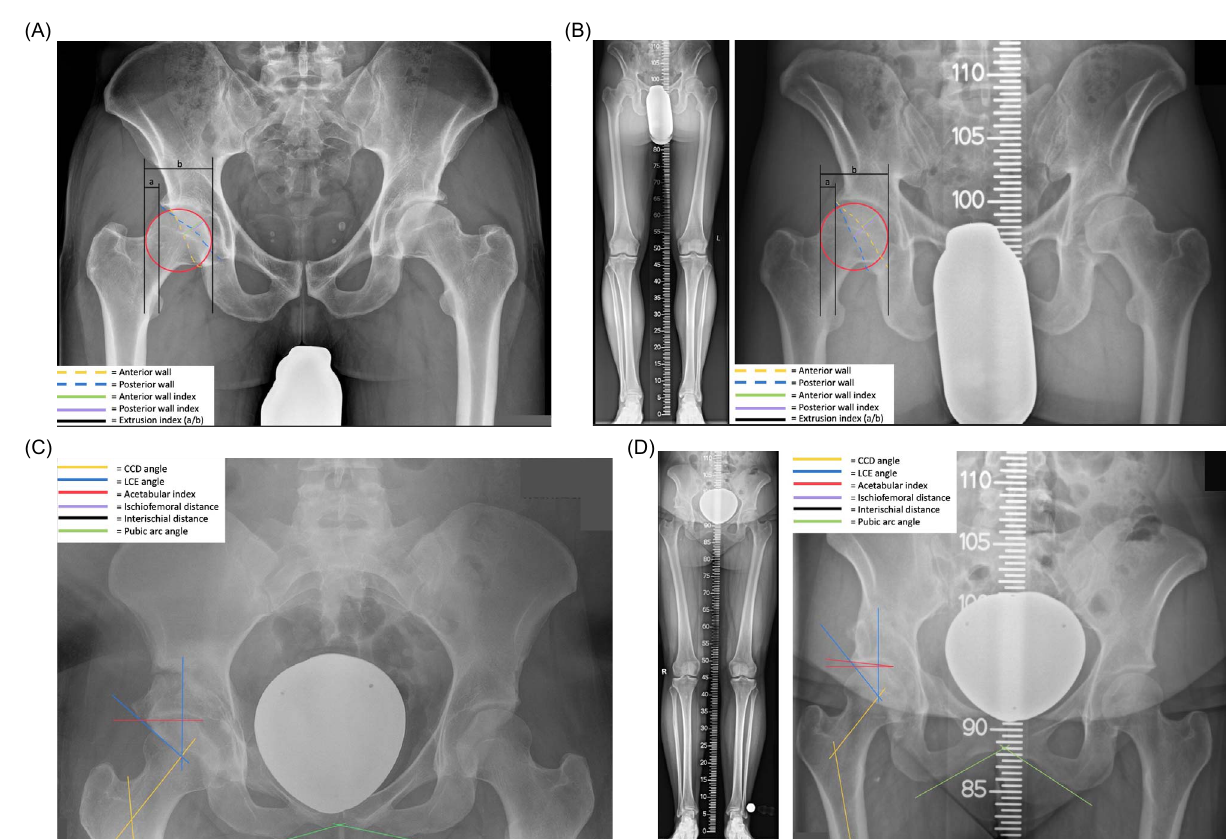
Figure 1. (a – d): Illustration of radiographic measures used for morphometric analysis of the hip in conventional ap pelvic X-rays and full- length weight-bearing radiographs. CCD: centrum collum diaphyseal angle, LCE: lateral center edge